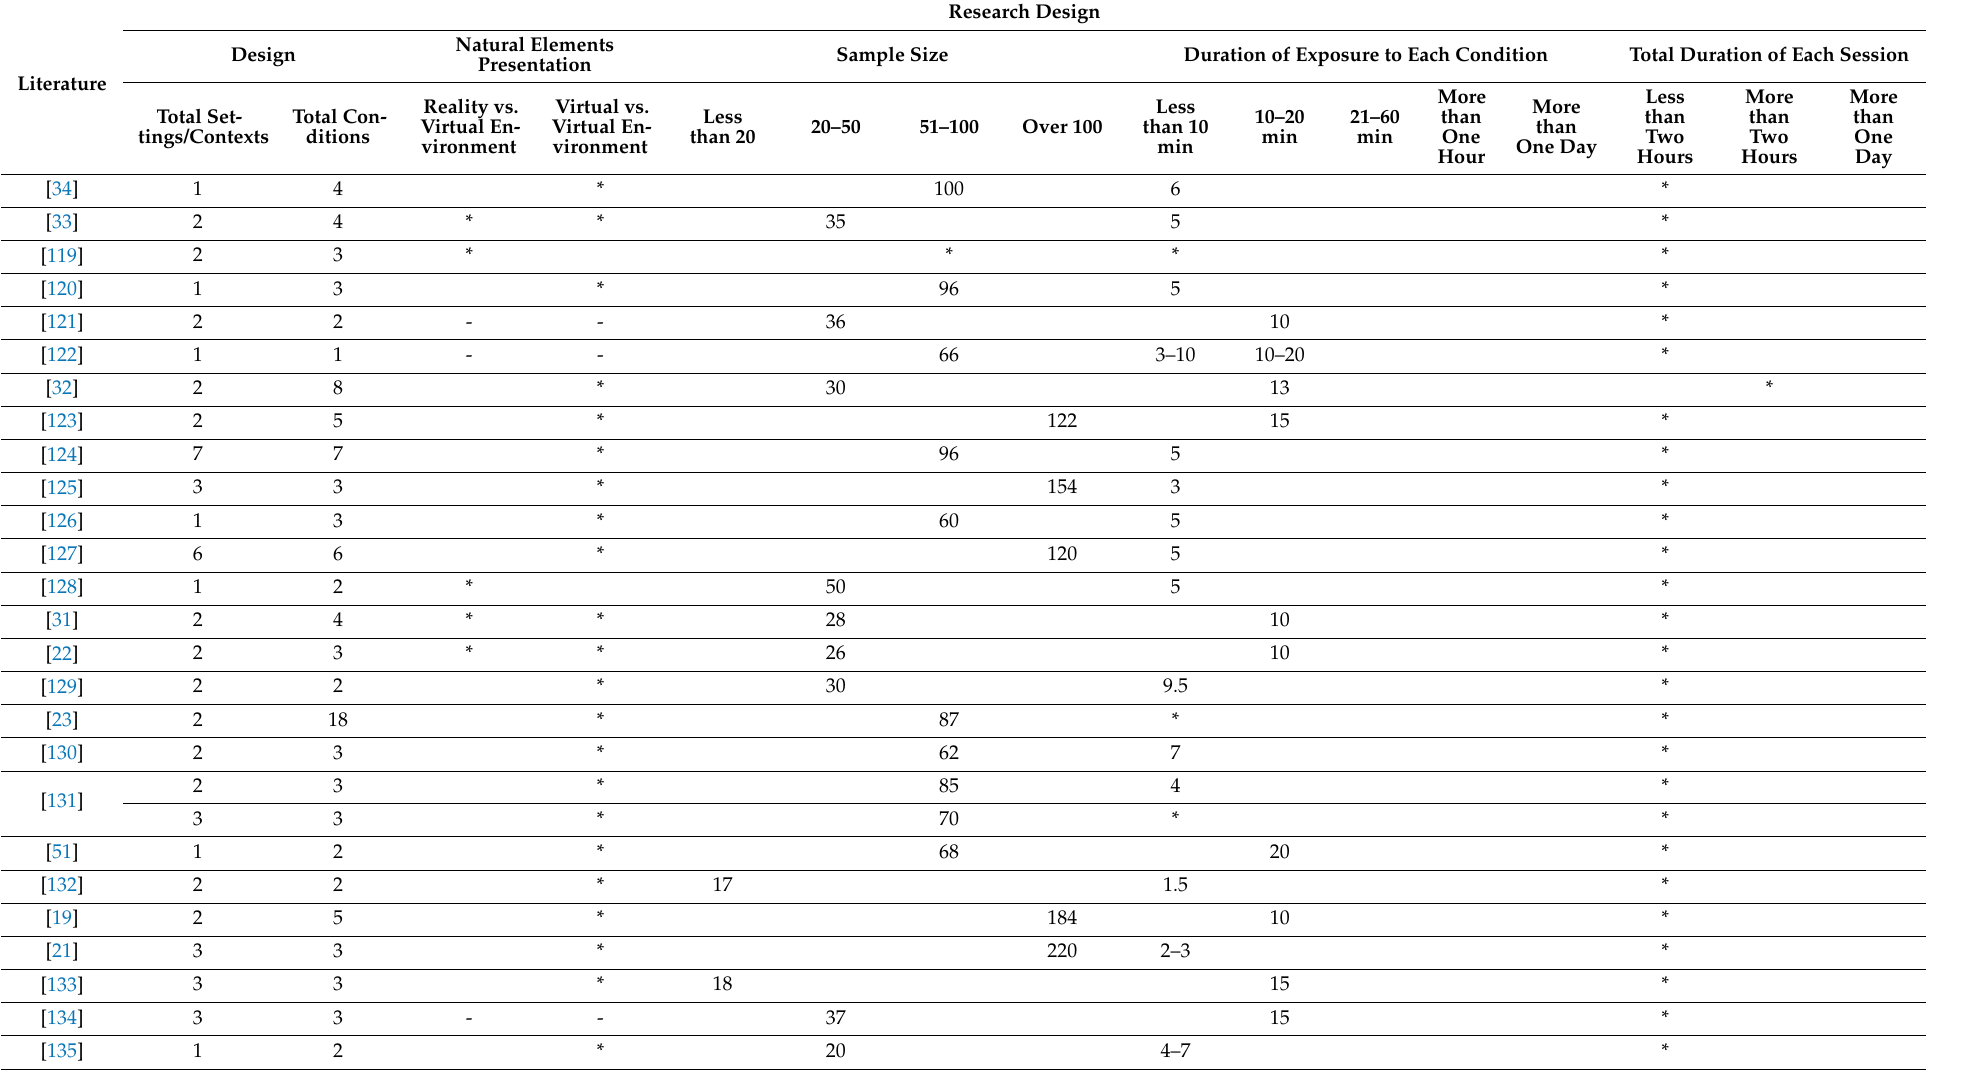
Table A5. Classification of the reviewed studies employing virtual natural environment (factors